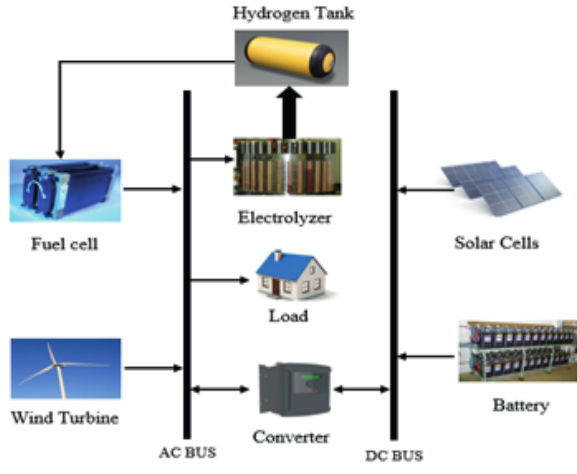
Fig. 1. Hybrid energy system